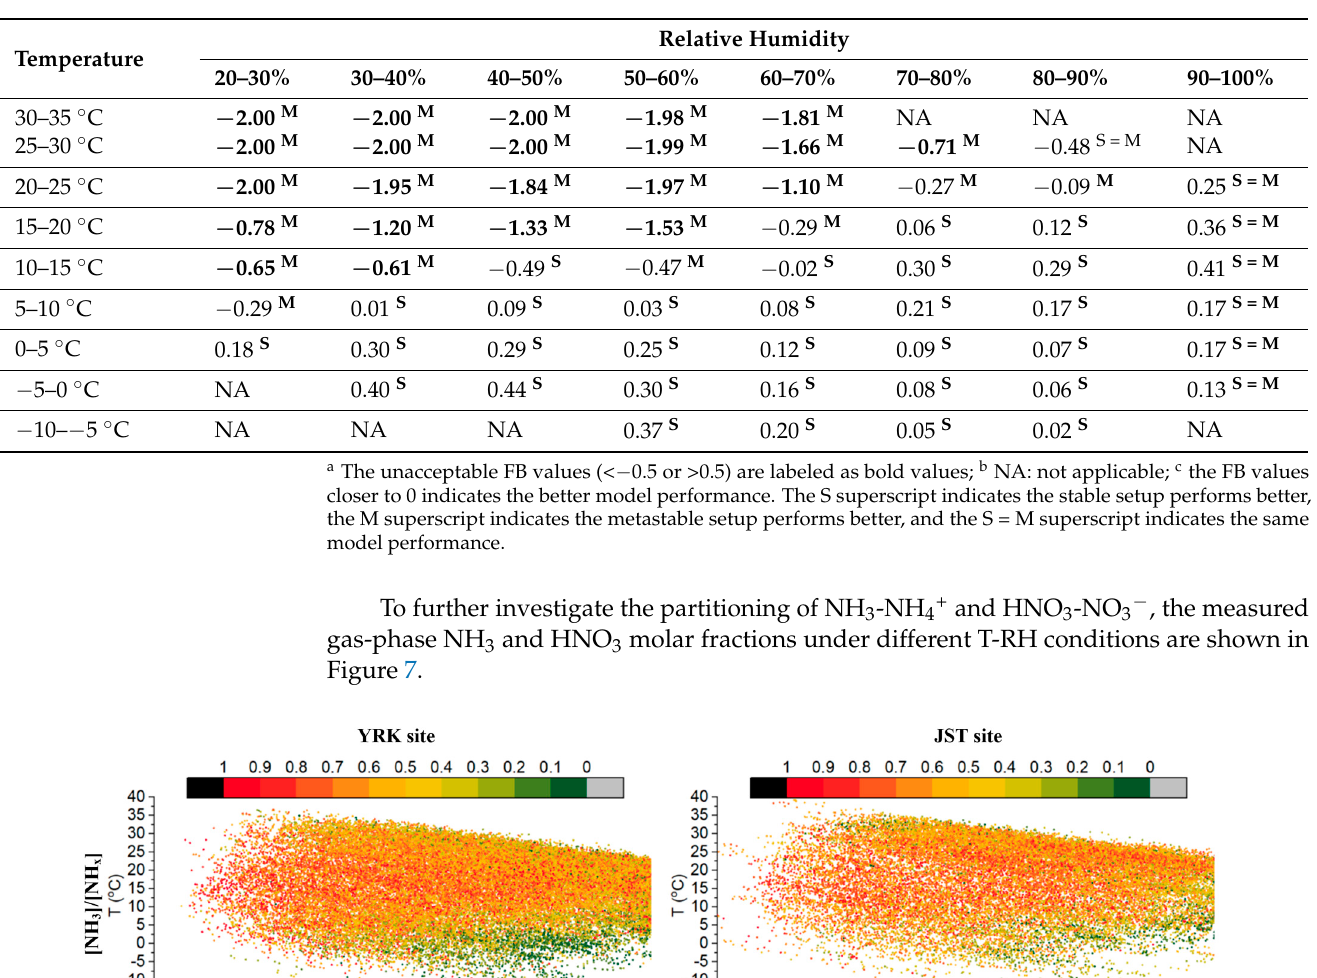
Table 2. Model performance assessment for NO 3 − prediction with stable setup at the YRK site.